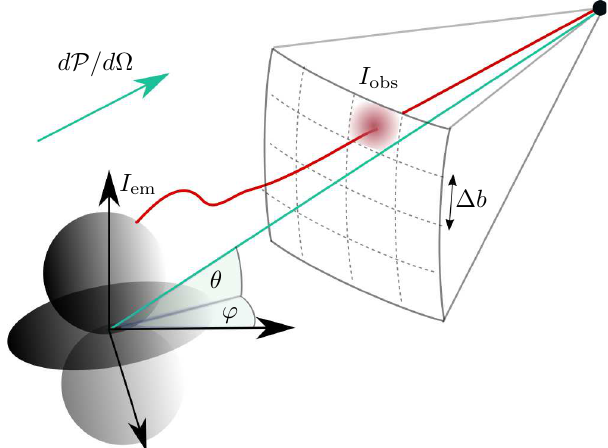
Figure 1 . Ray tracing geometry. A sketch of the ray tracing scheme. The image plane is divided into pixels side length ∆ b and lies perpendicular to the line of sight ( θ, ϕ ) in polar coordinates defined about the centre of the star. A ray (red) is back-traced from the center of each pixel towards the star. If the ray hits the critical surface, it is assigned an appropriate intensity I em according to the probability for axion-photon